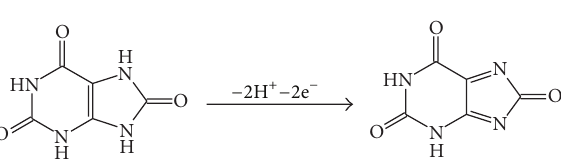
Figure 8: The electrochemical reaction mechanism for UA.